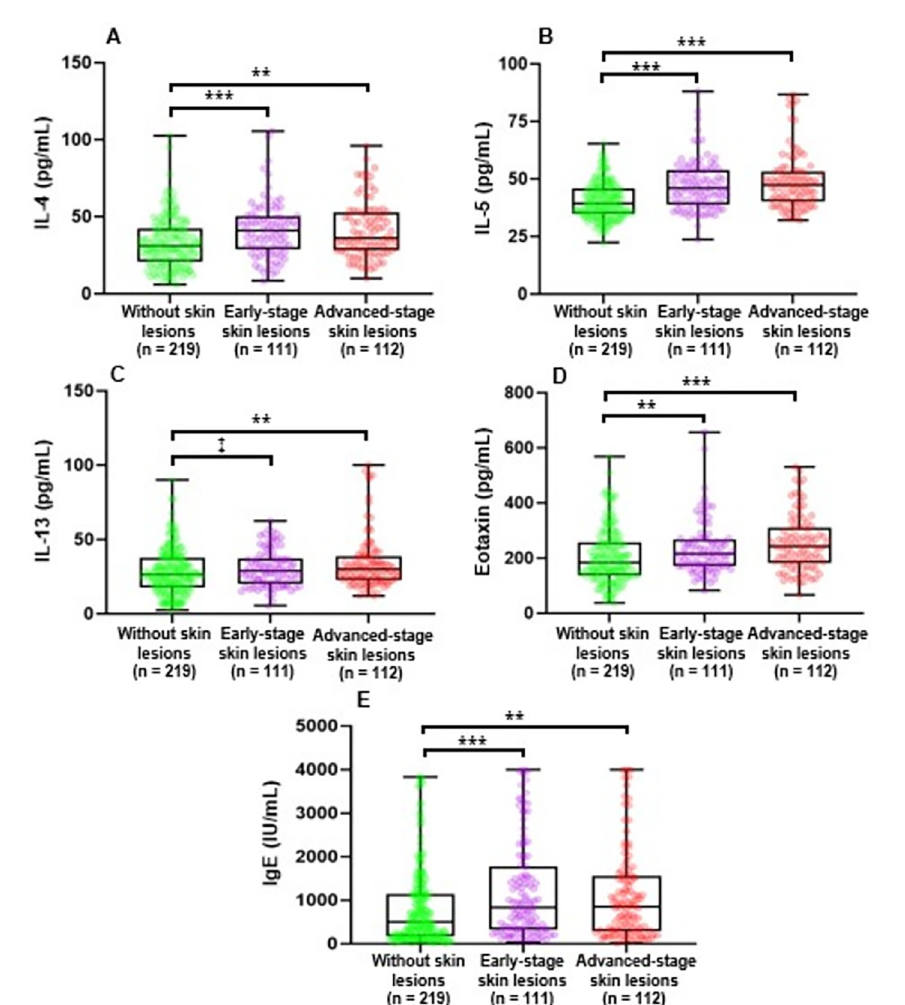
Fig 4. Comparisons of the levels of type 2 cytokines and IgE in the different stages of skin lesions using box and whisker plots. Comparisons of IL-4 (A), IL-5 (B), IL-13 (C), eotaxin (D), and IgE (E) levels between the groups of participants with and without skin lesions. The center line indicates the median value, the box contains the 25th to 75th percentiles of the dataset. The whiskers mark the minimum and maximum values. The dots show the individual data points. Mean rank differences were assessed by the Kruskal-Wallis test followed by Dunn-Bonferroni post hoc test between each skin lesions group. ��� p < 0.001; �� p < 0.01; ‡ p =